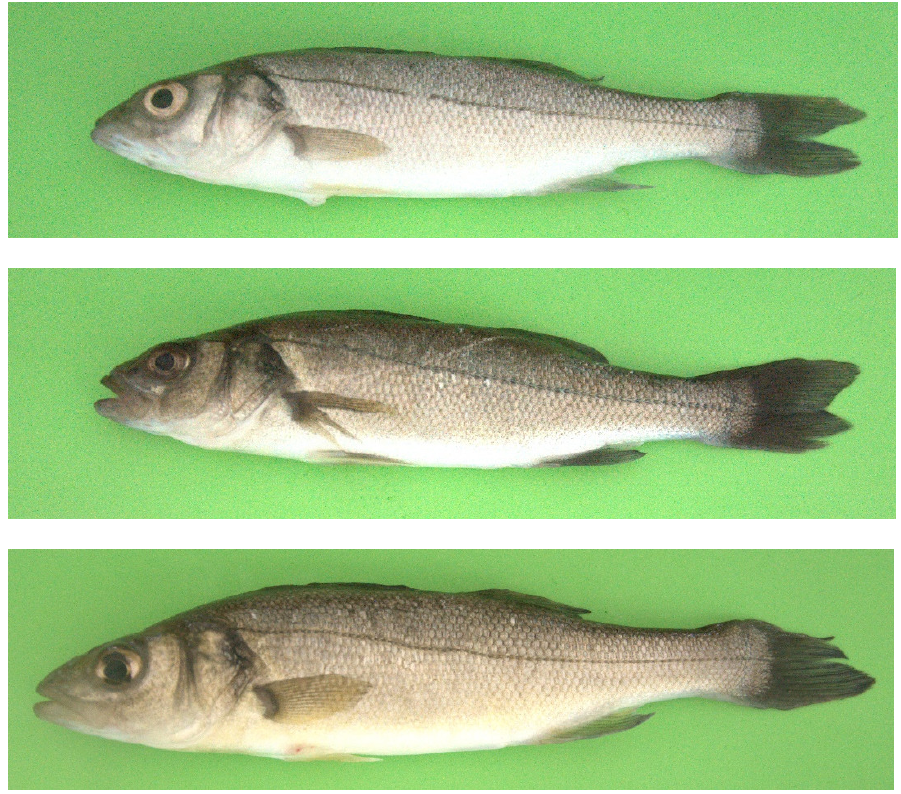
Figure 1. Examples of seabass images. ( Top ) example of the interrupted lateral line. ( Middle ) exam- ple of a fish with scratches visible on its body. ( Bottom ) example of a missing upper-tail